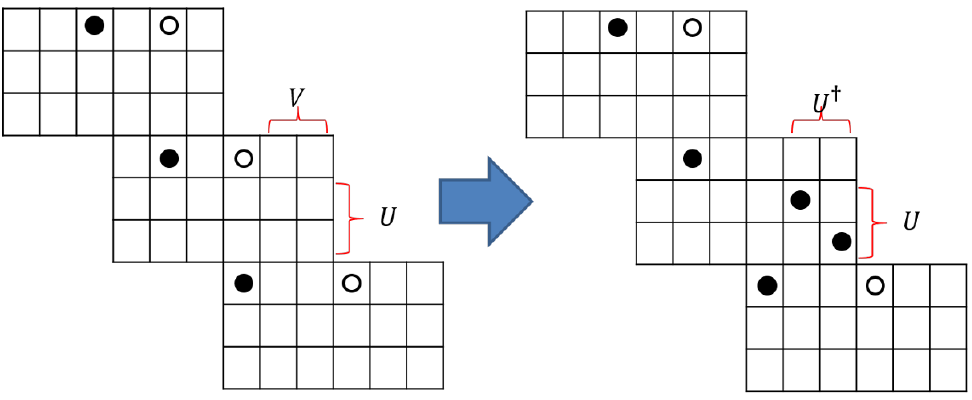
Figure 4 . This (cid:12)gure shows the contamination of a mesonic chain on the left to a mixed chain containing two baryons, on the right. It is also shown how two independent SU( N (cid:0) 1) symmetries of the mesonic chain, labelled by the matrices U; V are broken to the diagonal combination V = U y due to the